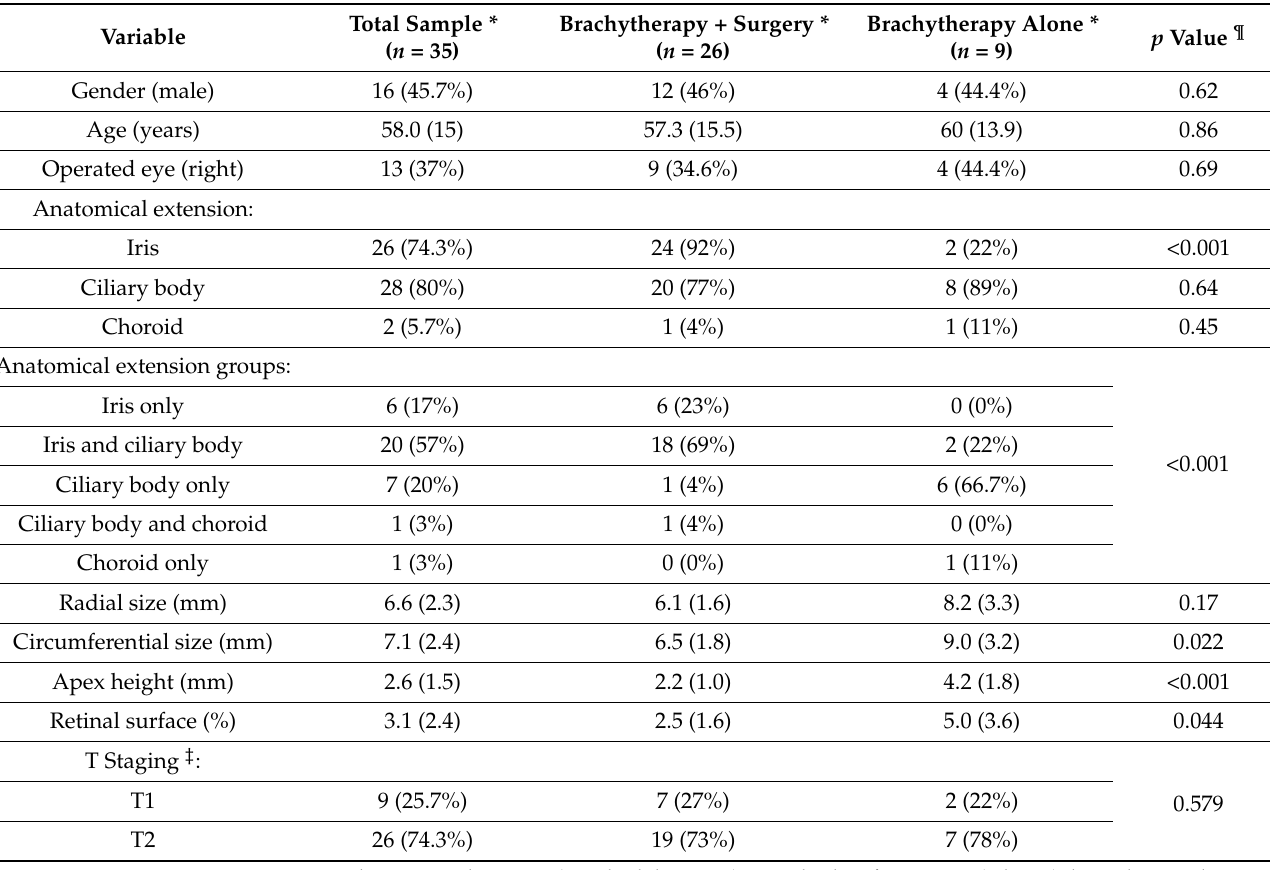
Table 1. Description of the 35 cases included according to the initial approach.